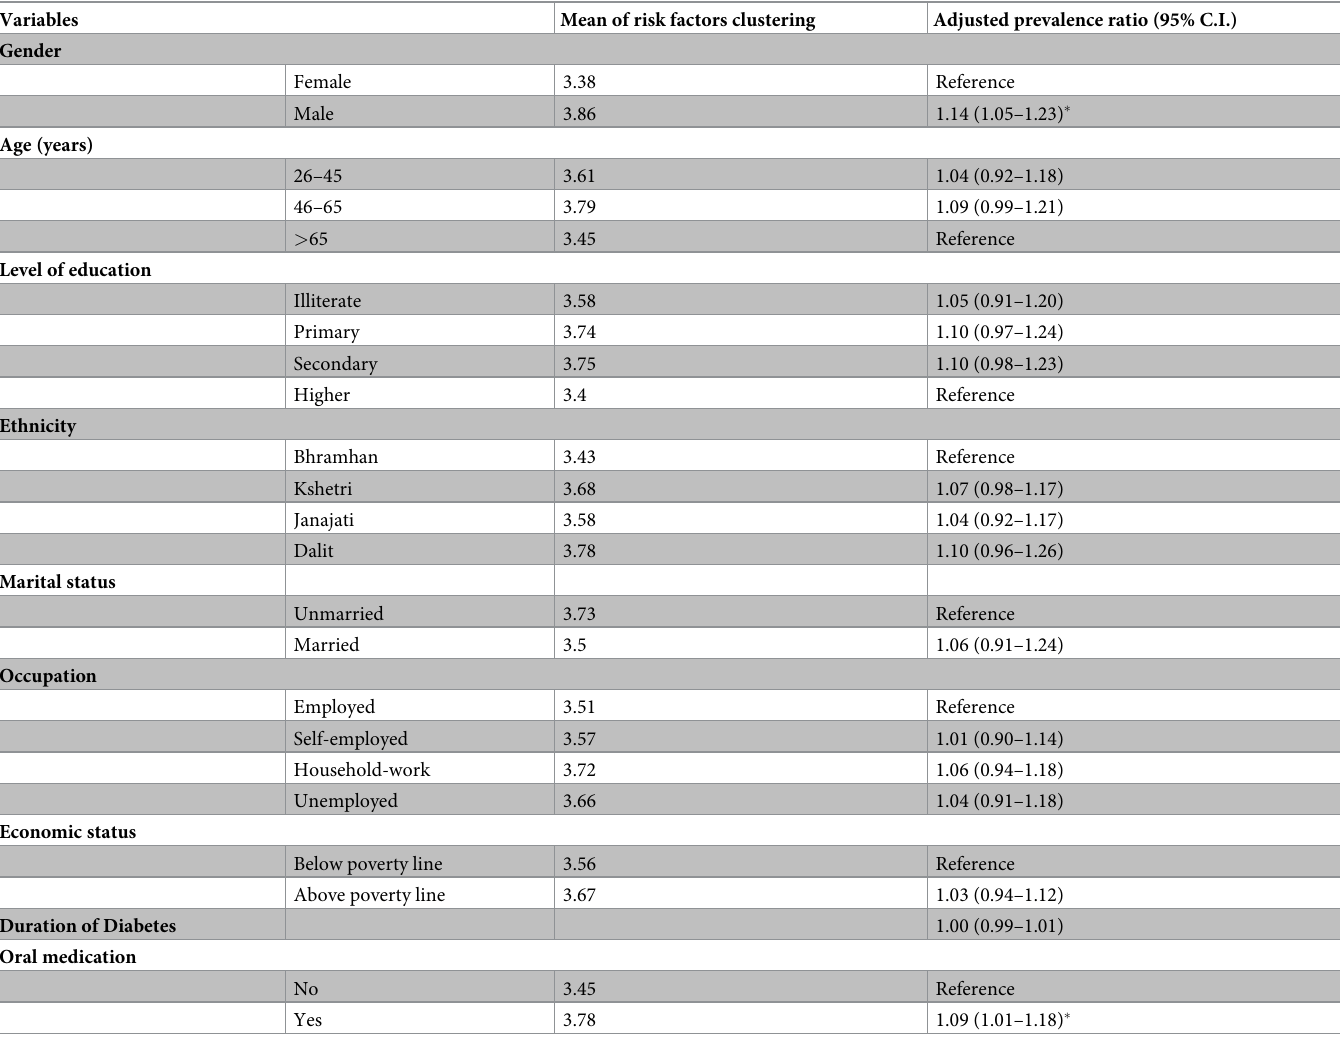
Table 6. Determinants of clustering of CVD risk factors (Poisson regression